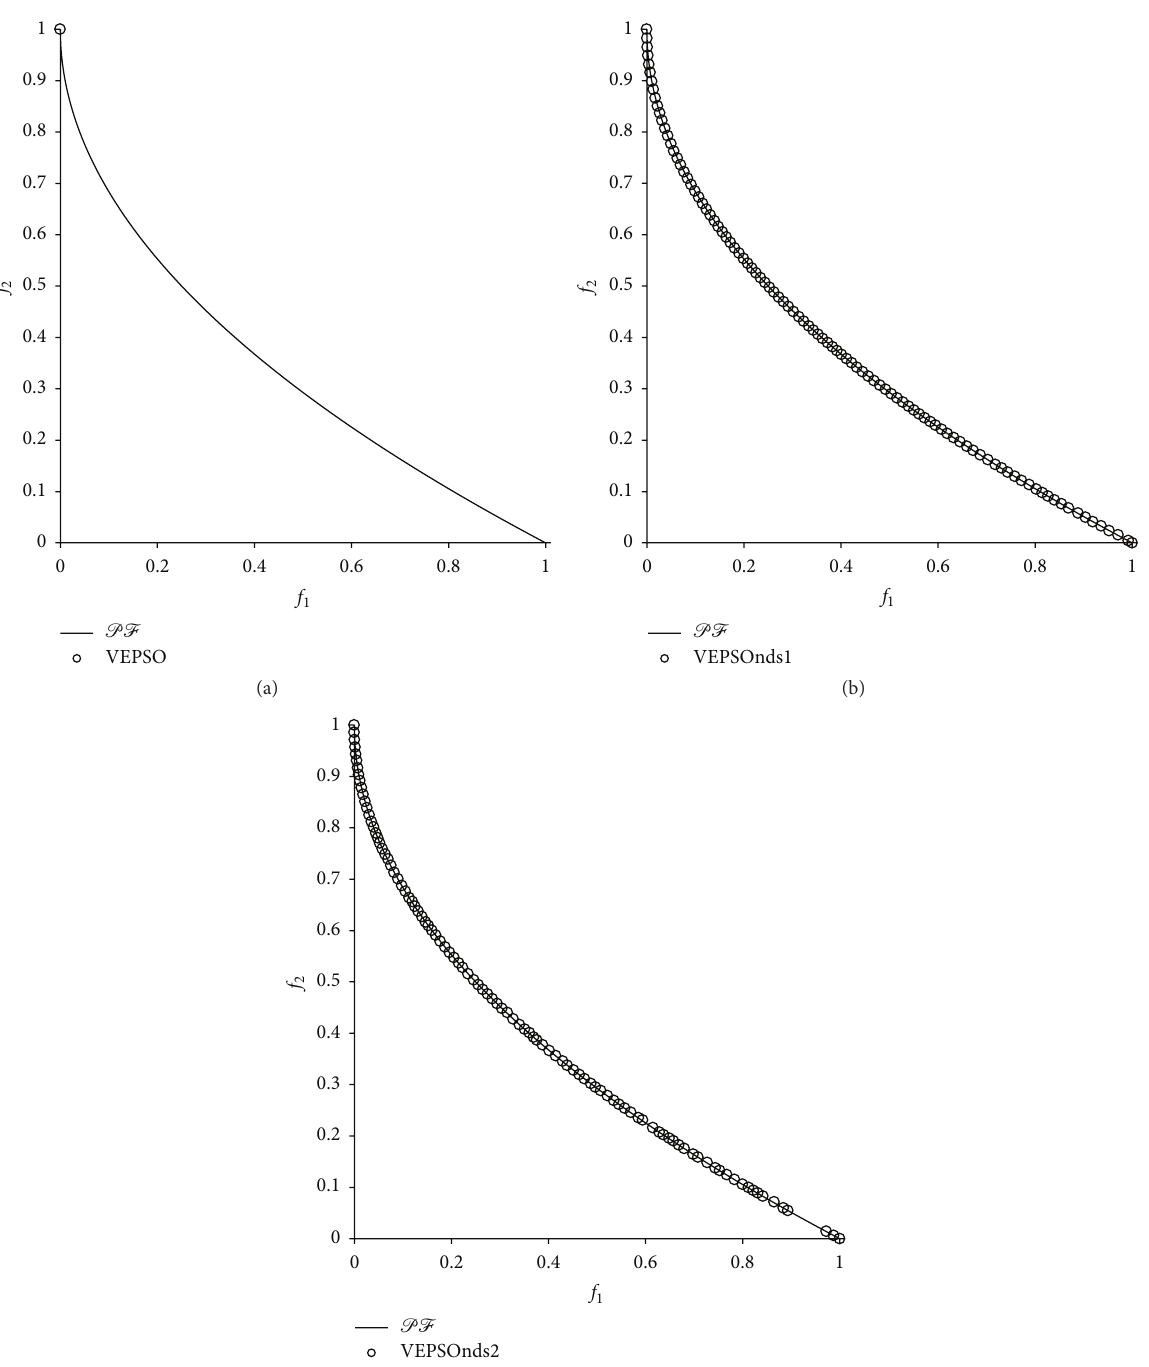
Figure 8: Plot of nondominated solutions returned by each algorithm for the ZDT4 test